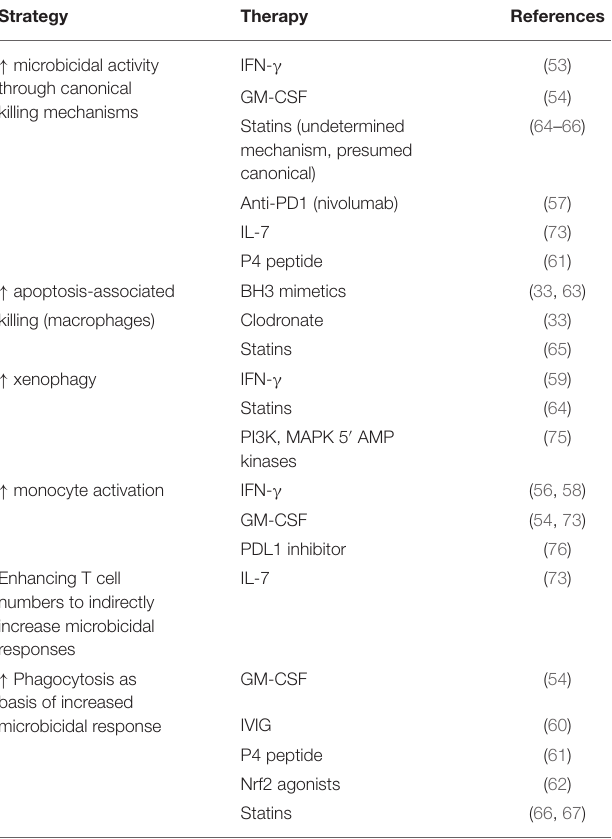
TABLE 2 | Summary of strategies of host-directed therapy.